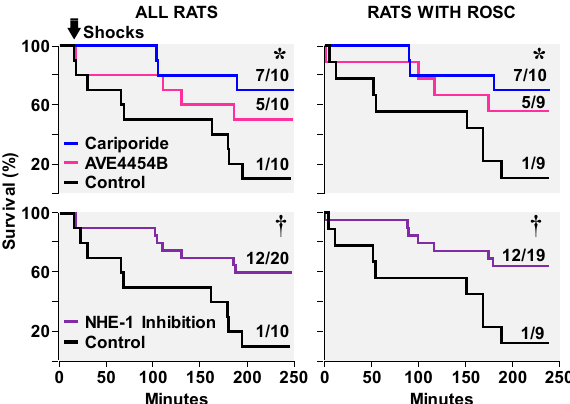
Figure 7. Survival curves in rats that received cariporide, AVE4454B, or control solution at the start of chest compression during resuscitation from VF. Shown are survival curves for all rats and survival curves only for rats that had return of spontaneous circulation (ROSC) after defibrillation (Shocks). Top graphs depict survival for the individual interventions. Bottom graphs depict survival for the cariporide and AVE4454B groups combined (NHE-1 Inhibition). ∗ p < 0.01 vs. control by Gehan-Breslow analysis using Holm-Sidak’s test for multiple comparisons; † p = 0.01 vs. control by Gehan-Breslow analysis (adapted with permission from Radhakrishnan et al. [22]).